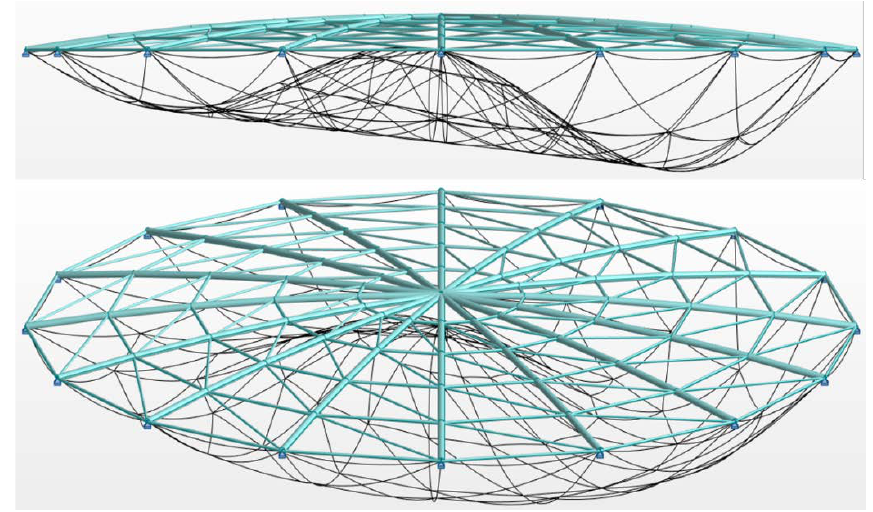
Figure 19. Ribbed dome deformation included wind load. Table 11. Values of the internal forces and the maximum horizontal and vertical displacement of node 9 for LA.